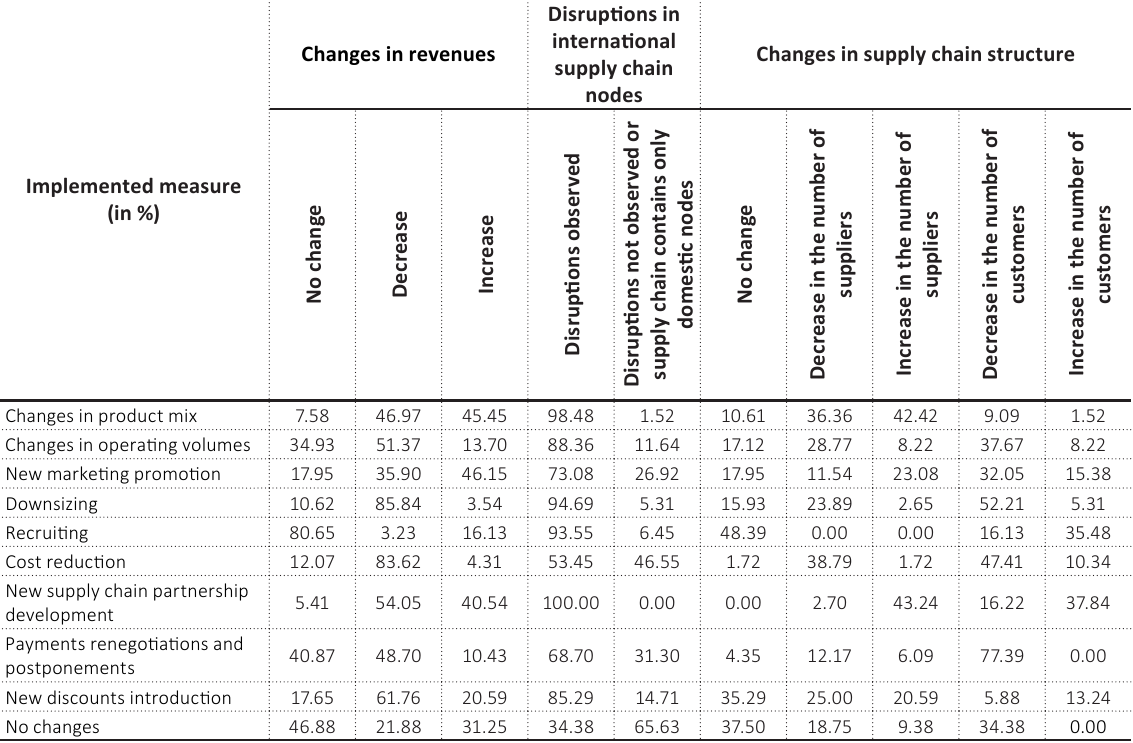
Table 6. Measures implemented in the context of changes and disruptions in supply chains